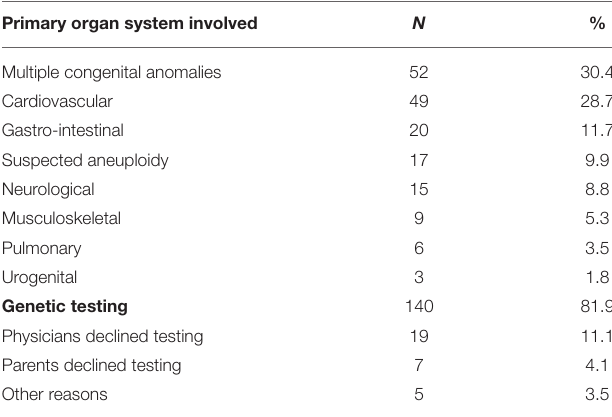
TABLE 1 | Characteristics of 171 included